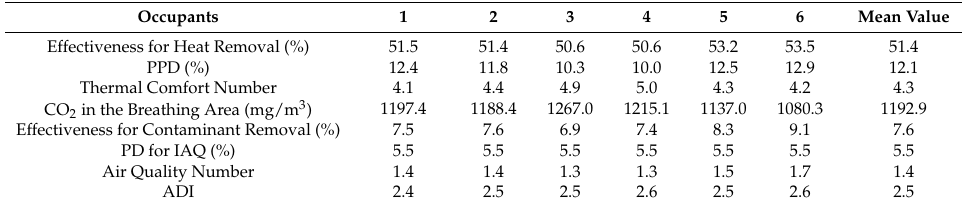
Table 2. Air distribution index (ADI) for an occupation of 6 persons with an inlet air temperature of 20 ◦ C.